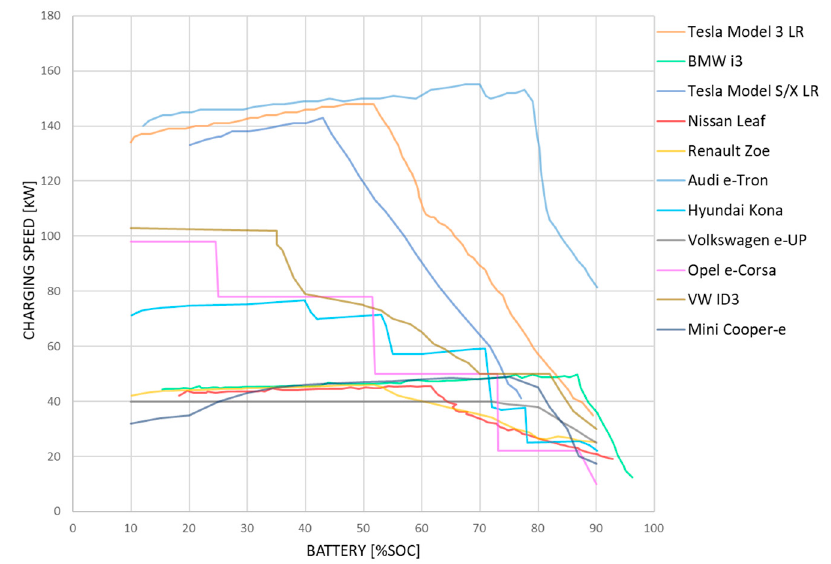
Figure 1. Charging profiles of different EVs.